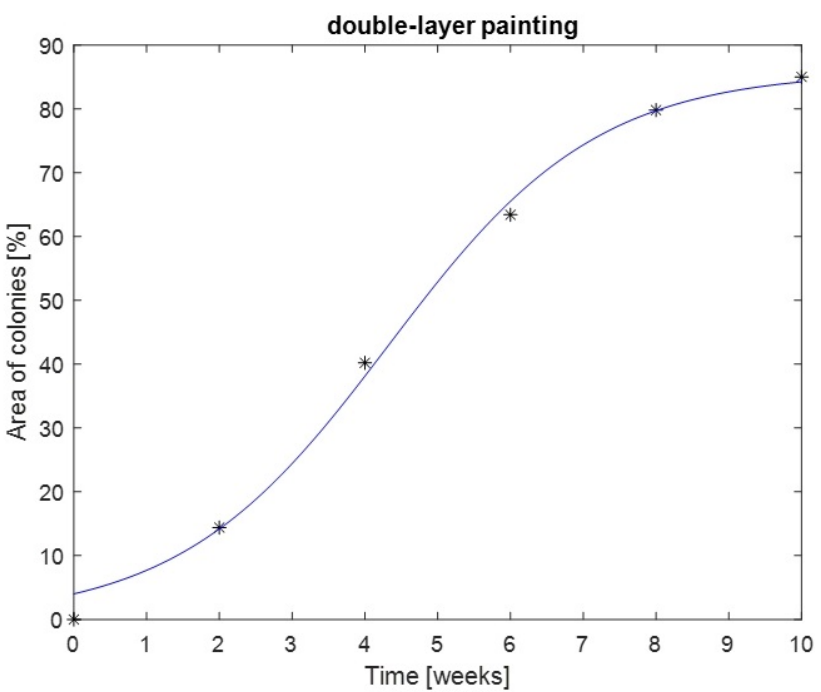
Figure 5. Approximation of colonies growth with a logistics curve for the double-layer paint coat- ing.